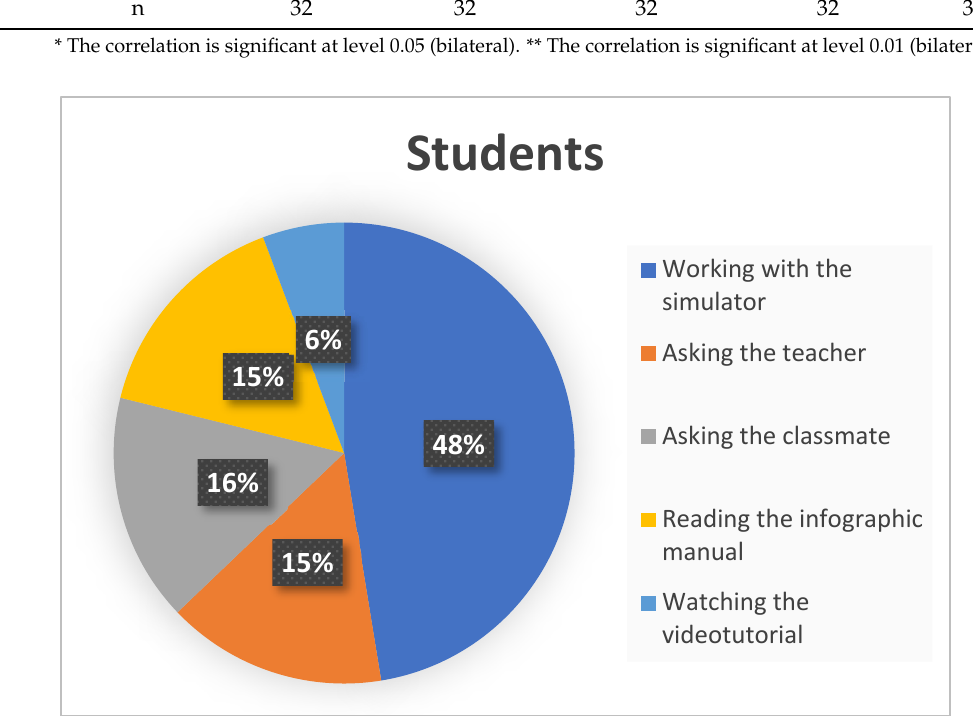
Figure 7. Percentages of the most effective strategies for knowledge/learning of the simulator in the teacher´s sample.